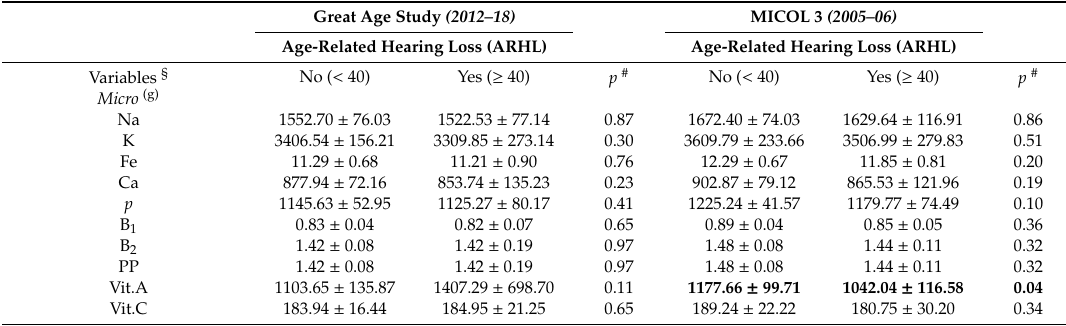
Table 3. Micronutrients intake characteristics of the population at baseline (M3) and follow-up (GreatAGE Study, M4) ( n =